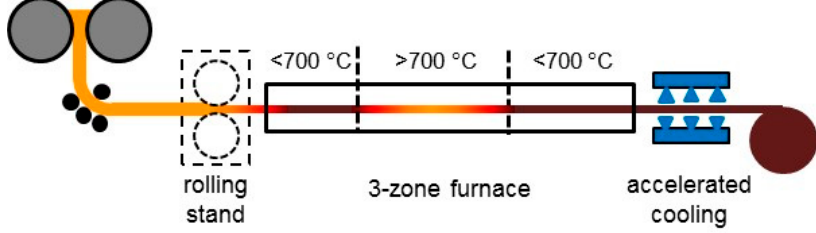
Figure 1. A schematic presentation of the modified strip casting.